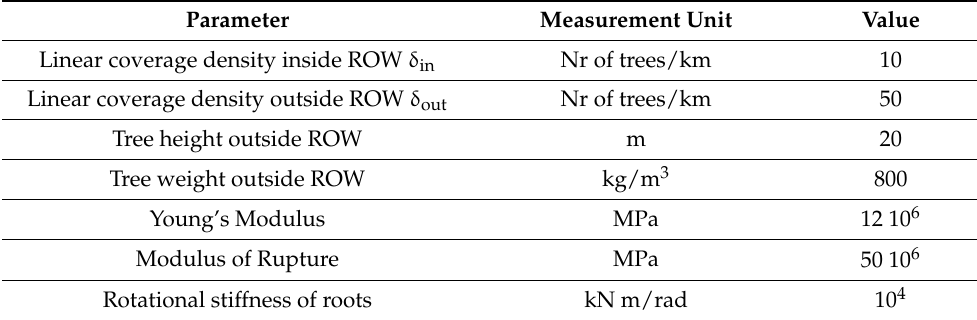
Table 2. Expected values for the parameters of tree forests in the studied region. Parameter Measurement Unit Value Linear coverage density inside ROW δ in Nr of trees/km 10 Linear coverage density outside ROW δ out Nr of trees/km 50 Tree height outside ROW m 20 Tree weight outside ROW kg/m 3 800 Young’s Modulus MPa 12 10 6 Modulus of Rupture MPa 50 10 6 Rotational stiffness of roots kN m/rad 10